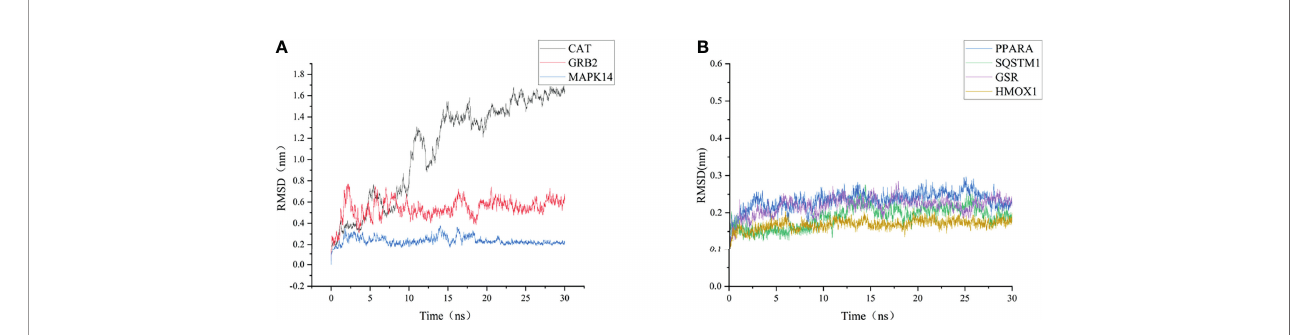
FIGURE 6 | RMSD change of targets backbone atoms in MD simulation. (A) RMSD of CAT-CoQ10 complex, RMSD of GRB2-CoQ10 complex, RMSD of MAPK14- CoQ10 complex (B) RMSD of HMOX1-CoQ10 complex, RMSD of PPARA-CoQ10 complex, RMSD of SQSTM1-CoQ10 complex, RMSD of GSR-CoQ10